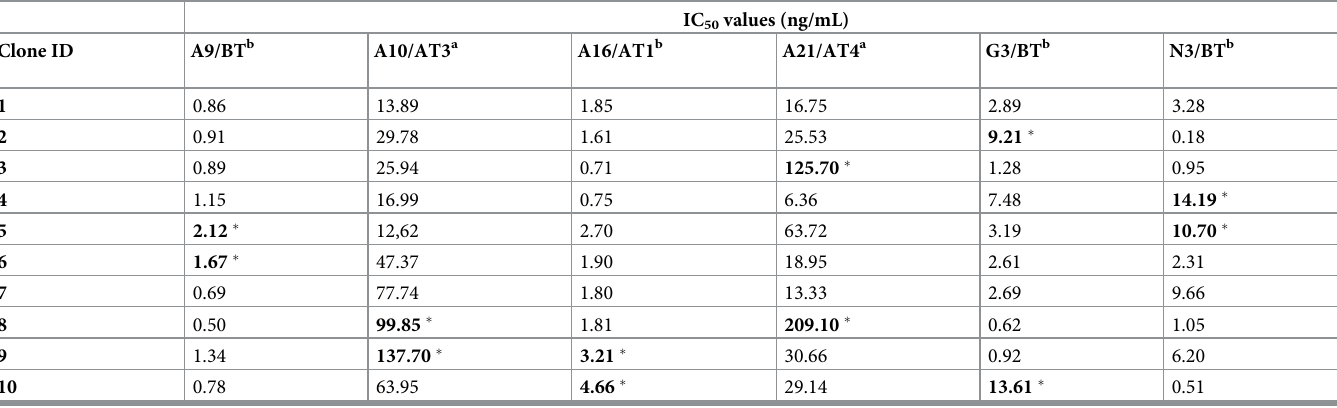
Table 1. IC 50 values of clonal cell lines derived from A9/BT, A10/AT3, A16/AT1, A21/AT4, G3/BT and N3/BT isolates treated with buparvaquone. IC 50 values